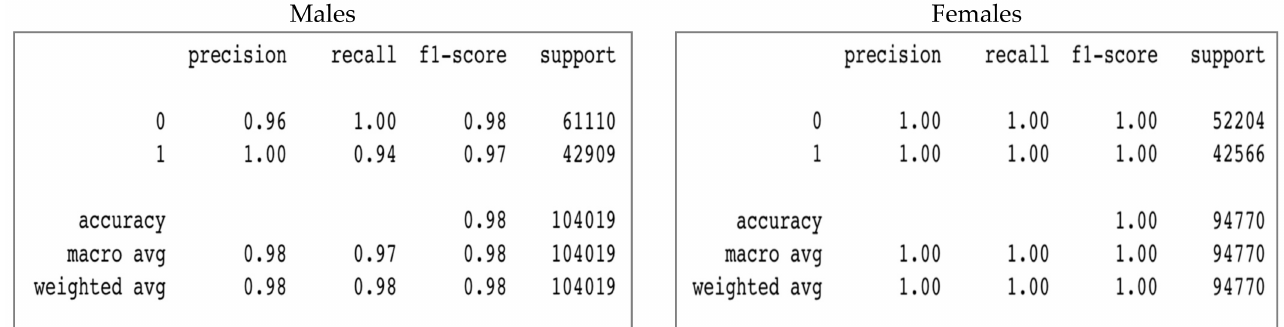
Figure 10. Classification reports for ResNet50’s experiment 3.